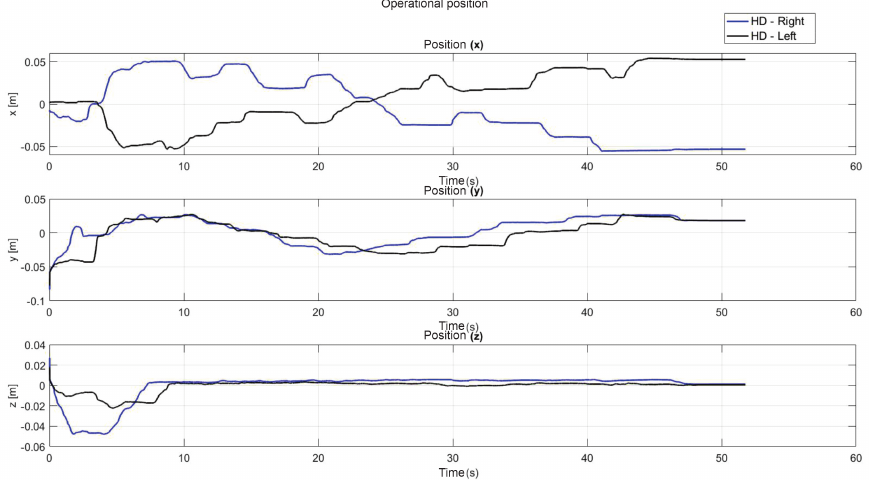
Figure 26. Operational position of two haptic devices in active haptic guidance task: exercise